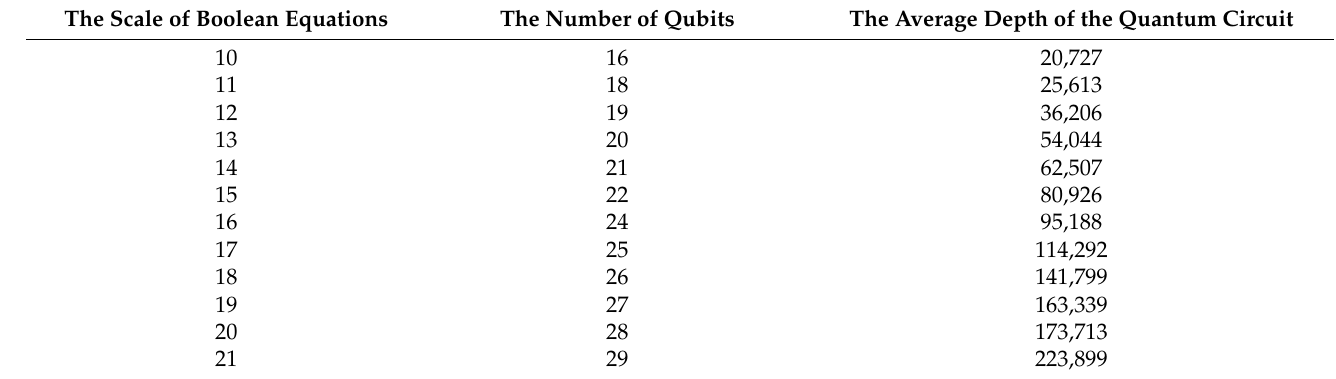
Table 2. Number of qubits and circuit depth required for Boolean equations of different